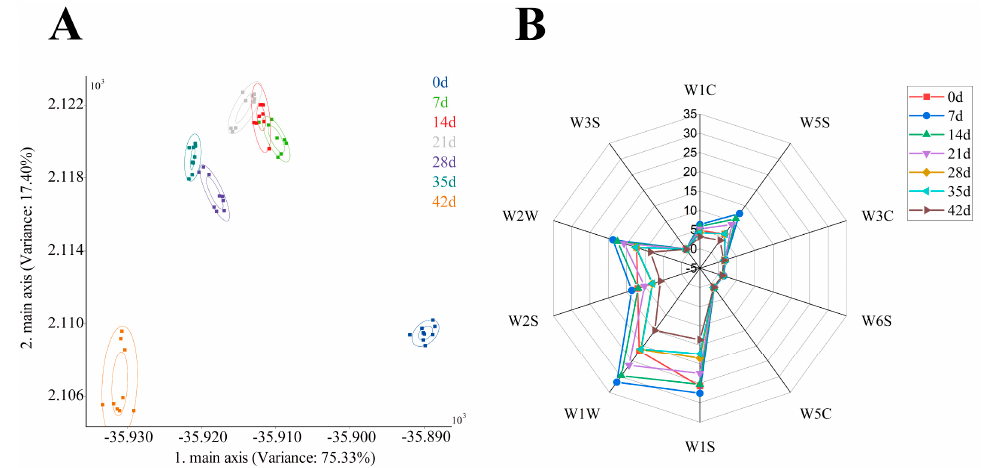
Figure 1. LDA analysis chart ( A ) and radar chart ( B ) of aroma at different times using the E-nose test.